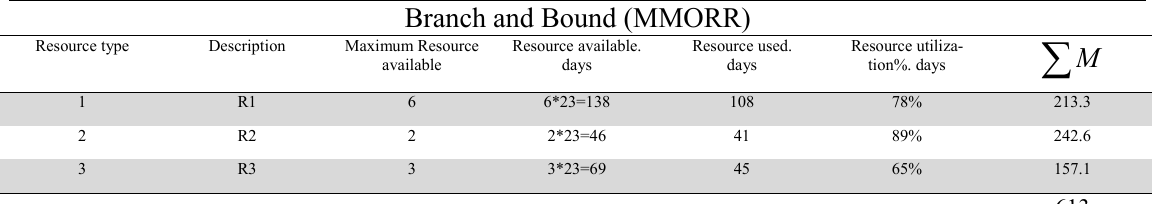
Branch and Bound (MMORR) Resource available. Resource used. available days days